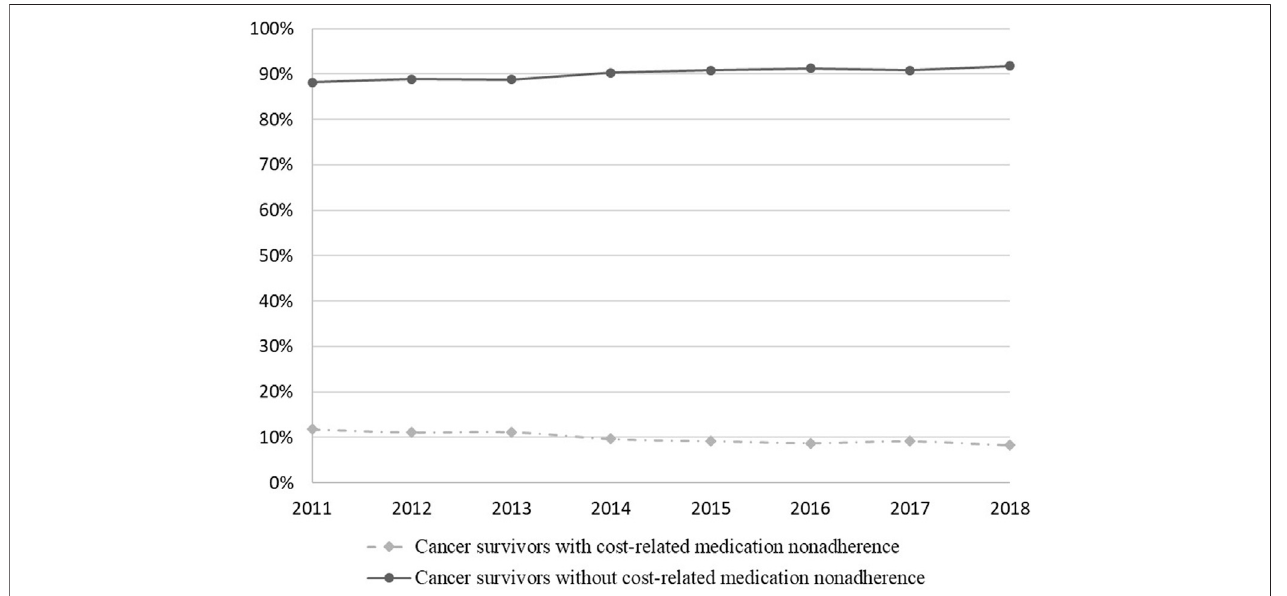
FIGURE 1 | Trend of cost-related medication nonadherence among cancer survivors between 2011 and 2018.